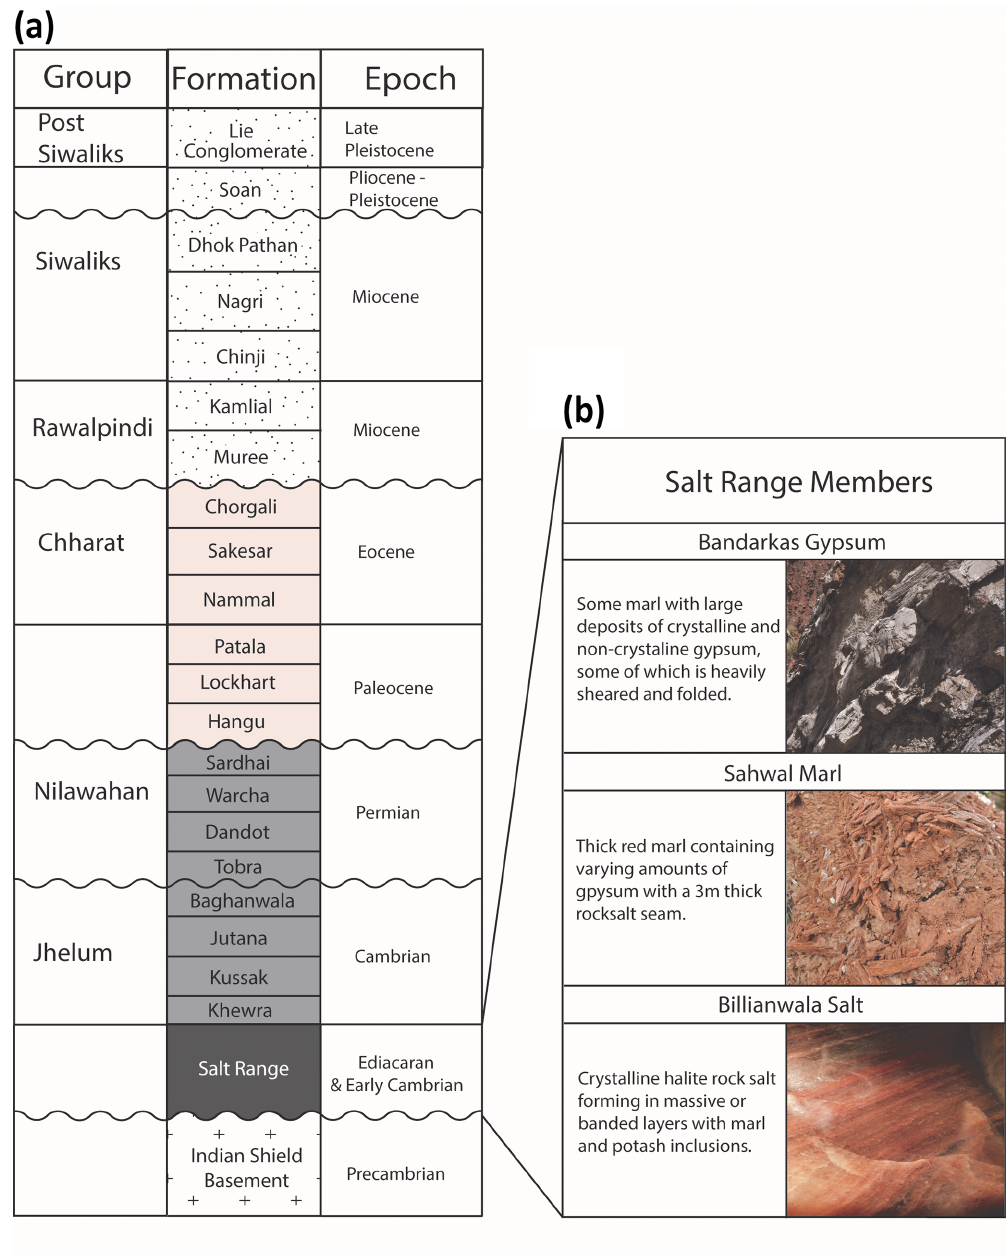
Figure 2. (a) Stratigraphic column of the units within the study area. (b) Salt Range Member subdivisions (after Richards et al., 2015).